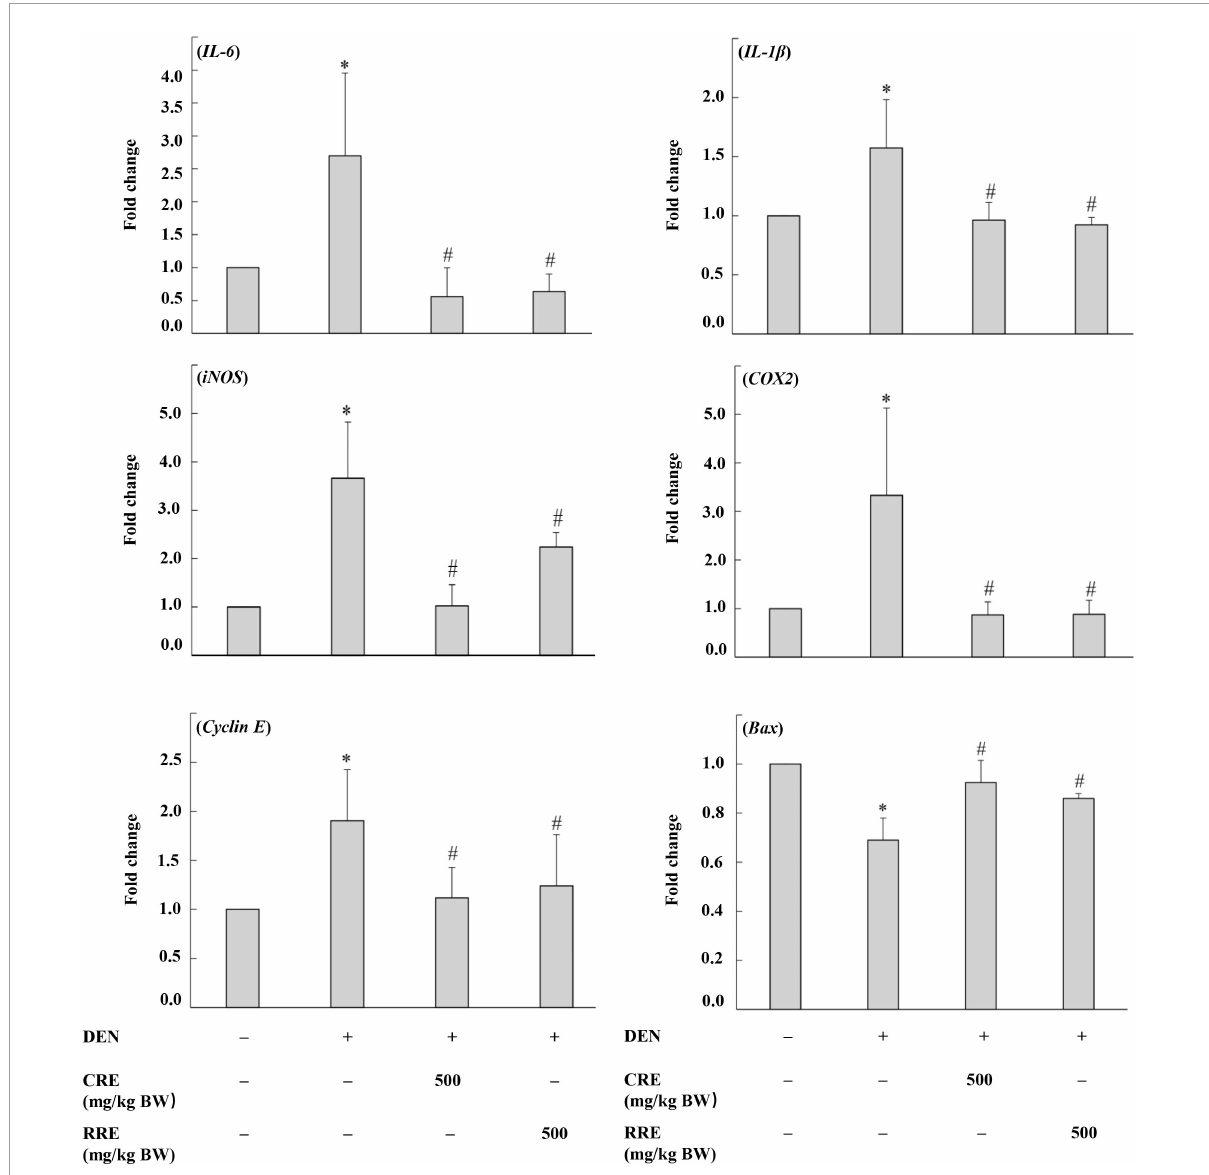
FIGURE6 Effect of cooked glutinous purple rice extracts on some related gene expression levels of rats. DEN, diethylnitrosamine; CRE, cooked glutinous purple rice extract; RRE, raw glutinous purple rice extract. Values are expressed as mean ± SD. ∗ Significantly different from the negative control group ( p < 0.05). # Significantly different from the positive control group ( p <